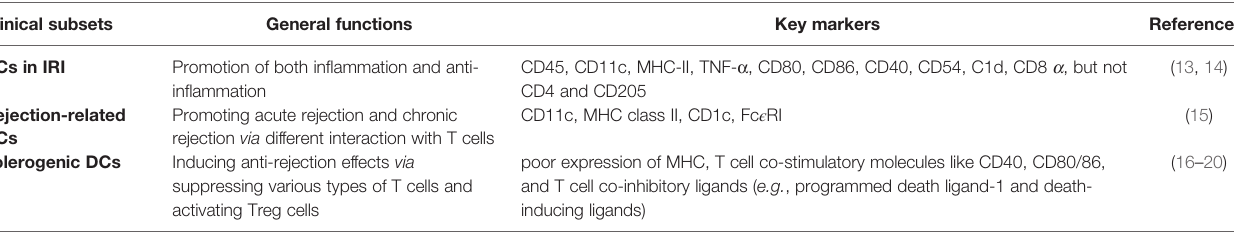
TABLE 1 | Remarkable features of three different types of DCs in renal